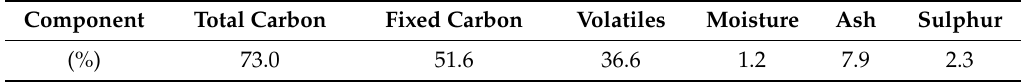
Table 2. Chemical analysis of the bituminous coal.